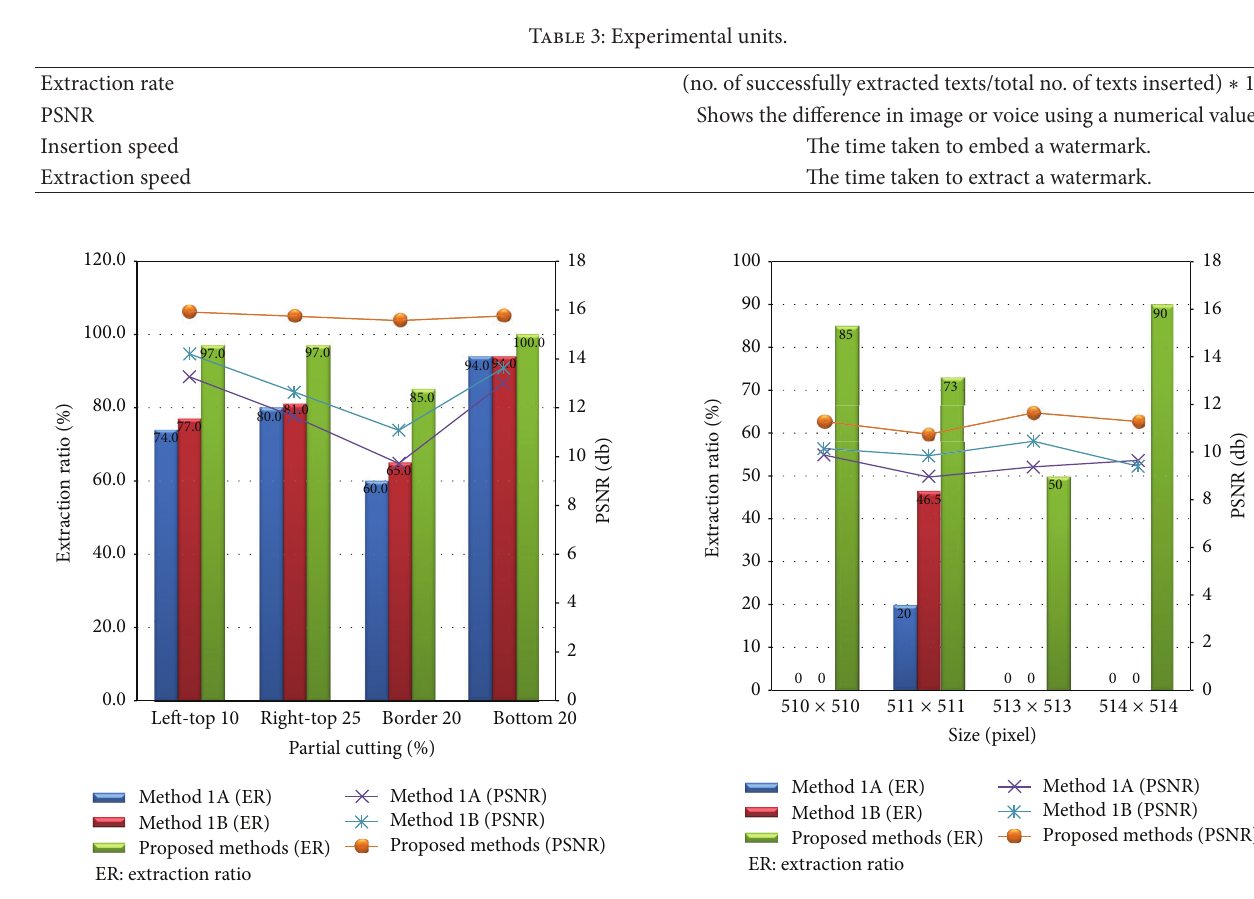
Figure 11: Extraction ratio and PSNR of partial cutting. Figure 12: Extraction ratio and PSNR in each